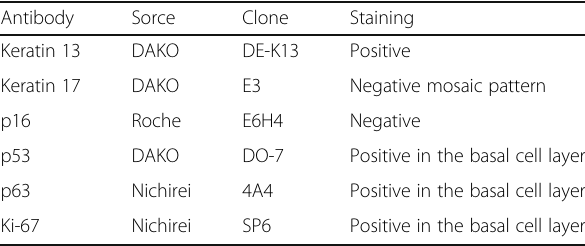
Table 1 Summary of immunohistochemical findings of the present case